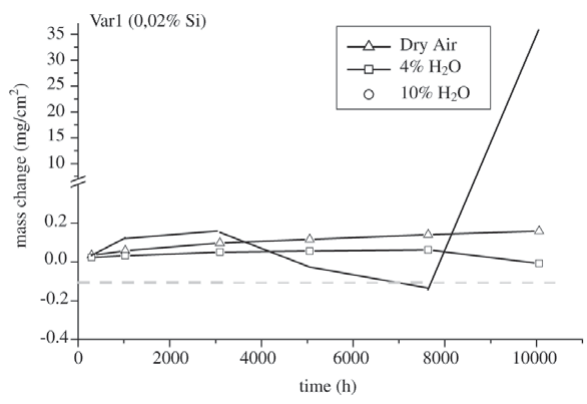
Figure 7. Results of mass change measurement as a function of time for Variation 1 of Nf616 at 650 °C in different environments.